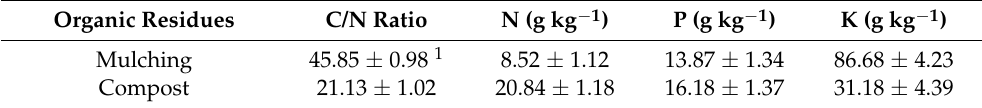
Table 1. Chemical composition (N, P, and K) of the organic residues used in the field experiment. Organic Residues